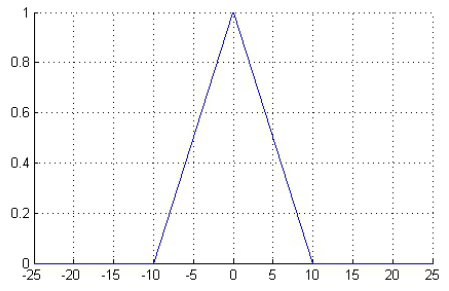
Figure 2. Schematic, triangular correlation function ( n